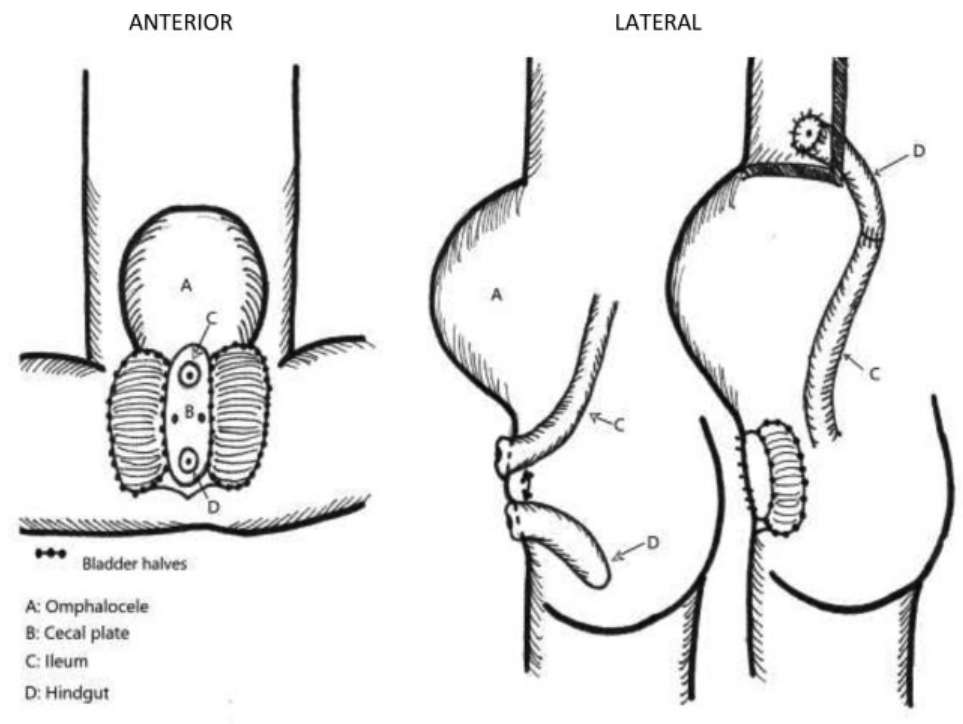
Fig. 5 Descriptive diagram of surgical intervention depicting anastomosis of ileum to hindgut once separated from the cecal plate. Bladder halves and cecal plate were left in situ due to the large